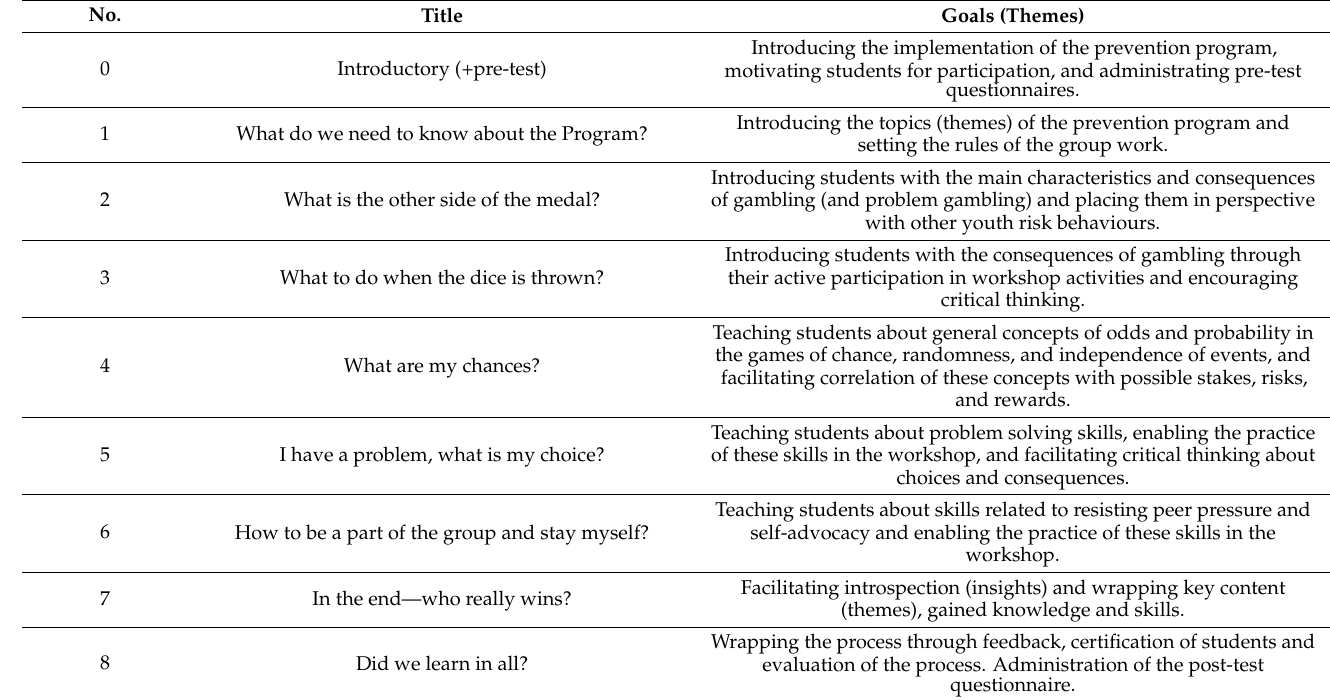
Table 1. Structure and the goals (themes) of the workshops within the youth gambling prevention program “Who Really